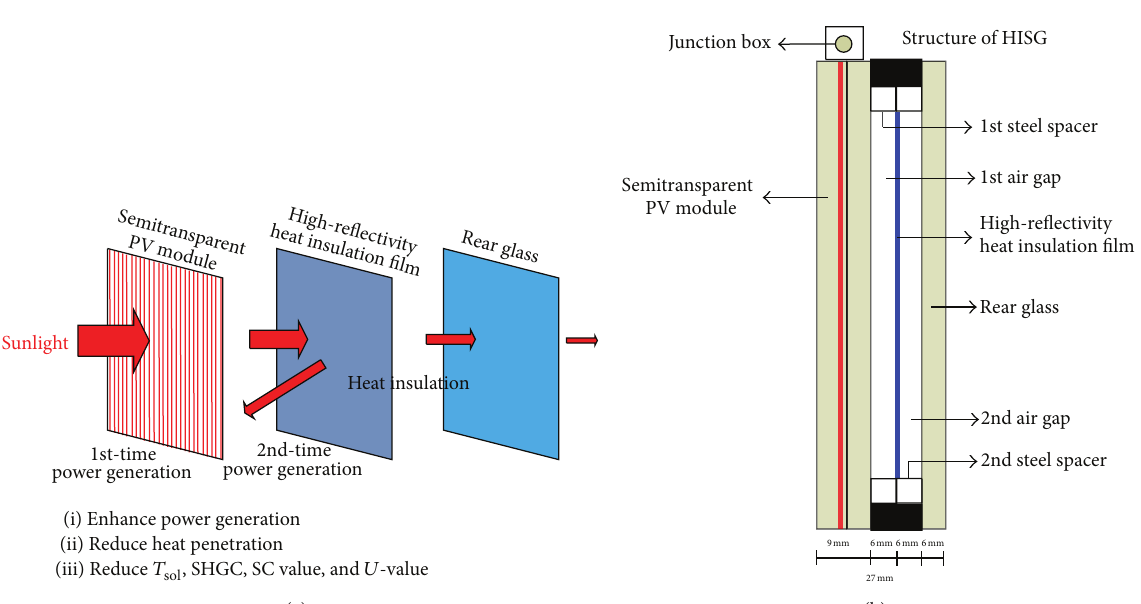
Figure 1: Functional principles and cross-sectional structure of heat insulation solar glass.